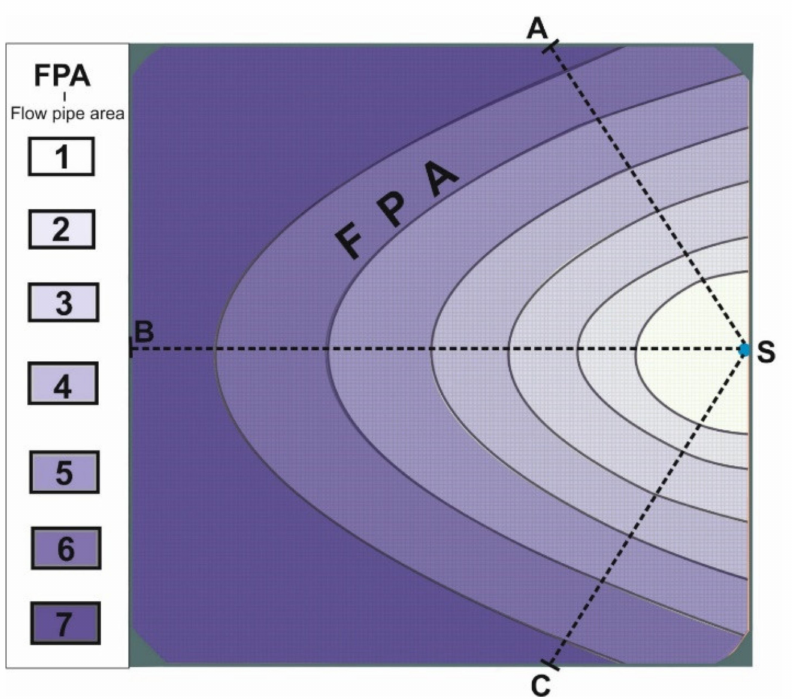
Figure 3. Plan-view of the starting path of the flow pipes (1, 2, 3, 4, 5, 6 and 7 from Figure 2) marked by di ff erent colors on the water table, drawn by interpolation from the